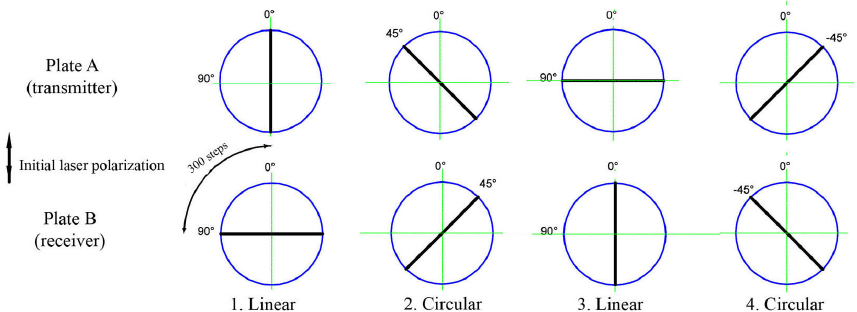
Figure 4. Diagram of the rotation of the phase plates. Plate mounting angles for the four consecutive laser pulses are shown. The bold line shows the direction of a fast axis of the plates.